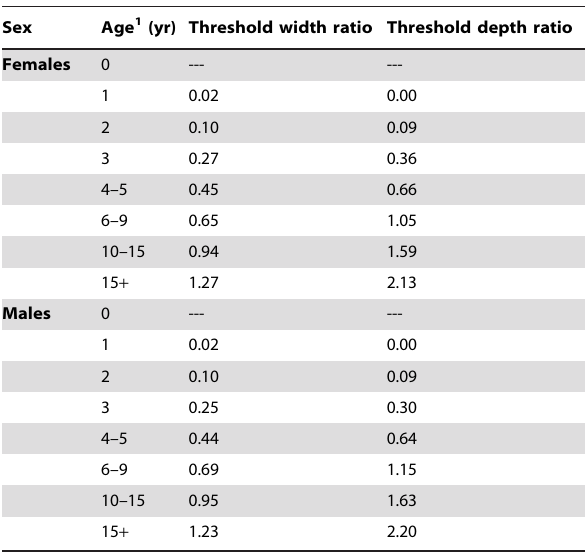
Table 1. Tusk:snout ratio threshold values used for assigning age based on measurements presented in Fay and Kelly [23] and calculated as the midpoints between the average ratios for each